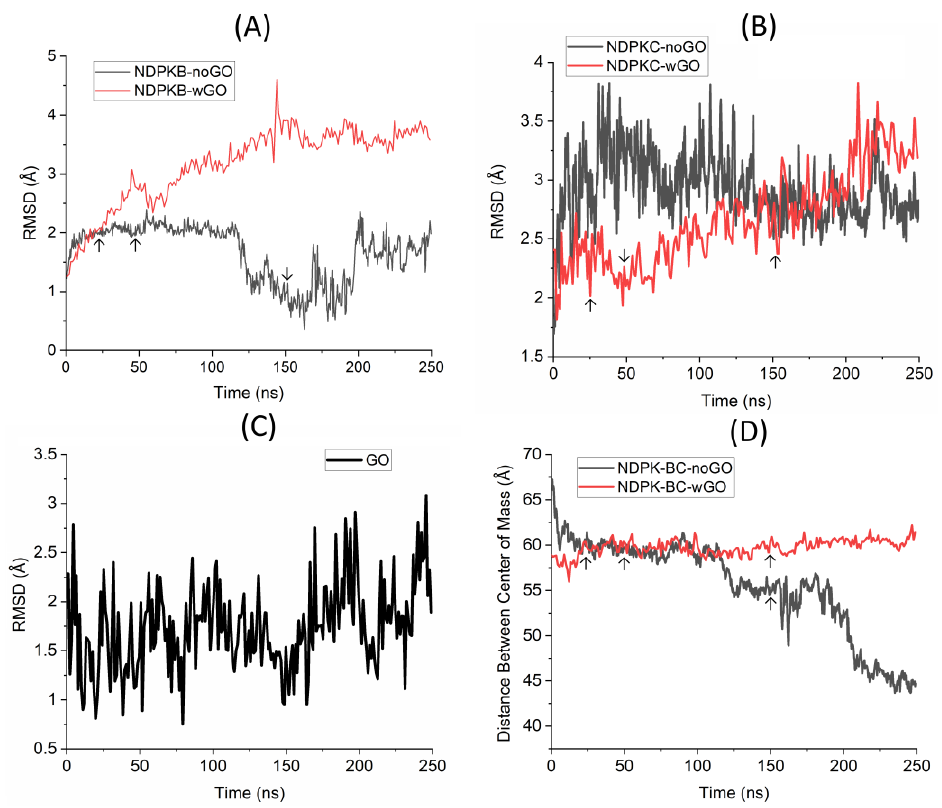
Figure 2. Stability Analysis of NDPK-B, NDPK-C in the presence and absence of graphene oxide: ( A ) RMSD of NDPK-B; ( B ) RMSD of NDPK-C; ( C ) RMSD of GO; ( D ) Distance between the center of masses (COM) of NDPK-B and NDPK-C. In all plots, noGO—no (absence of) GO; wGO—with (presence of) GO. The three important milestones in the trajectory at 25 ns, 50 ns and 150 ns are shown on the plots using the arrowheads.